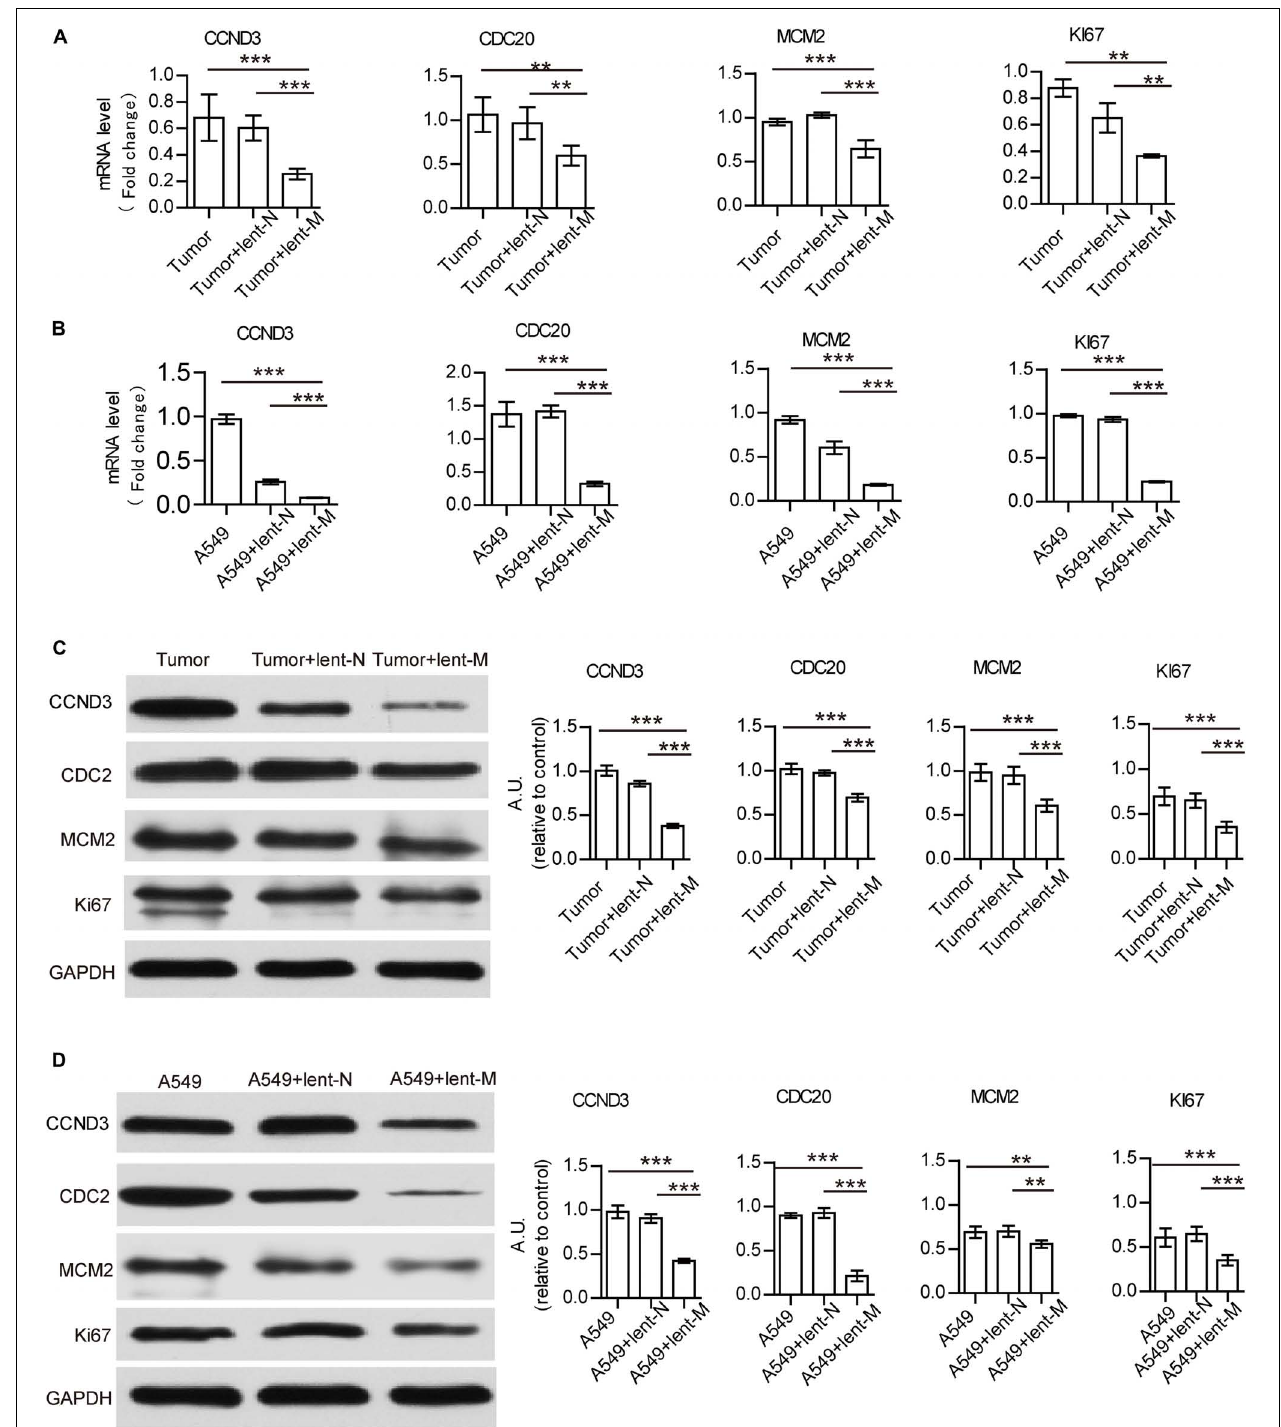
FIGURE 2 | MiR-138 treatment decreases the mRNA and protein expression levels of CCND3, CDC20, MCM2, and Ki67 in A549 tumors and A549 cells. (A) Lent-miR-138 treatment (lent-M) decreased the gene expression levels of CCND3, CDC20, MCM2, and Ki67 in tumors from A549 bearing mice, compared with the Lent-NC treated (lent-N) and non-treated tumors. (B) Decreased gene expression levels of CCND3, CDC20, MCM2, and Ki67 in lent-miR-138-5p treated A549 cells, lent-NC treated cells and untreated cells. (C) Lent-miR-138- treatment decreased the protein expression levels of CCND3, CDC20, MCM2, and Ki67 in A549 tumors or (D) A549 cells. (Three independent assays were performed; ** P < 0.01, *** P < 0.001).